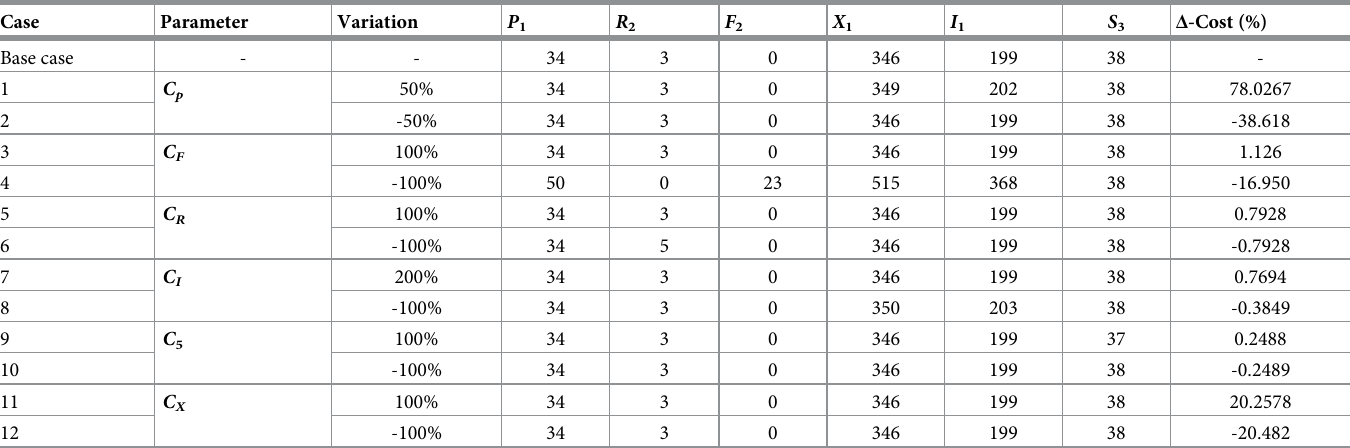
Table 8. Sensitivity analysis of Model-I. Own elaboration.